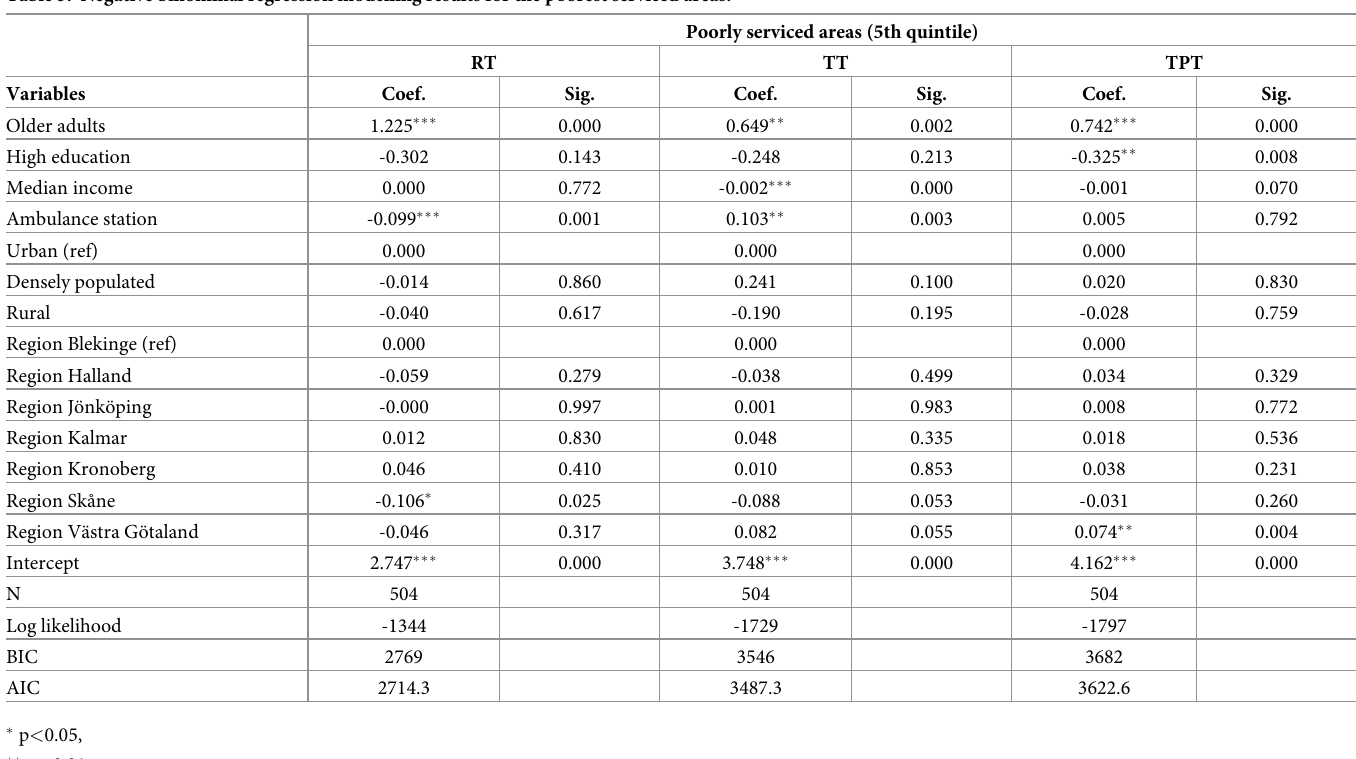
Table 3. Negative binominal regression modelling results for the poorest serviced